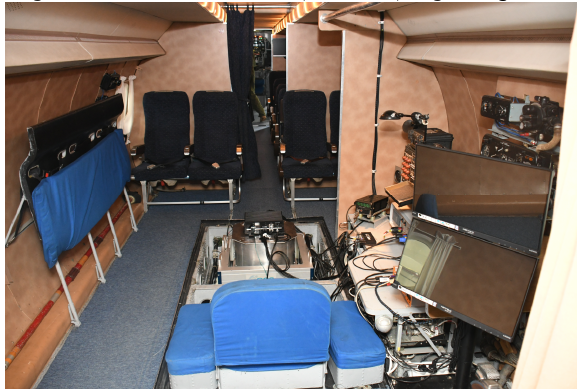
Figure 1 . RoDAS mounted in the Romanian Open Skies aircraft